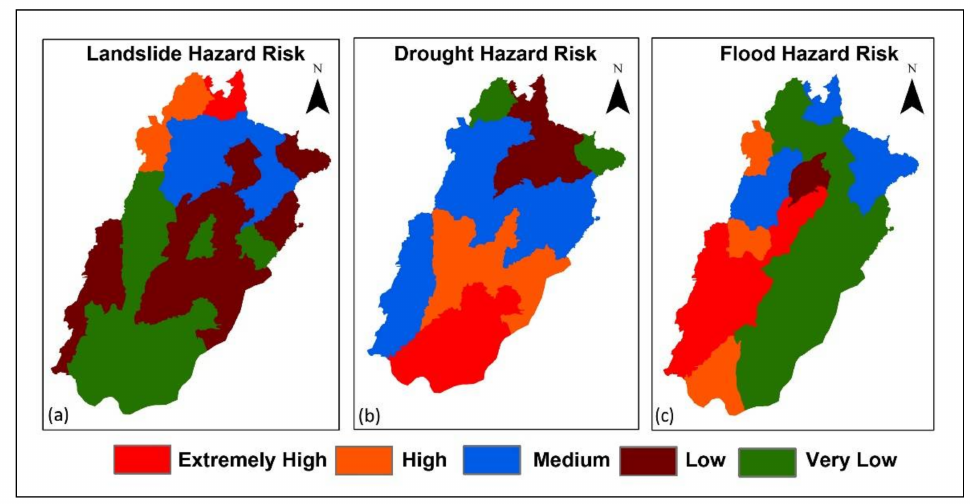
Figure A5. Maps of indicators belonging to hazards group (G5): ( a ) landslide hazard risk; ( b ) drought hazard risk; ( c ) flood hazard risk.